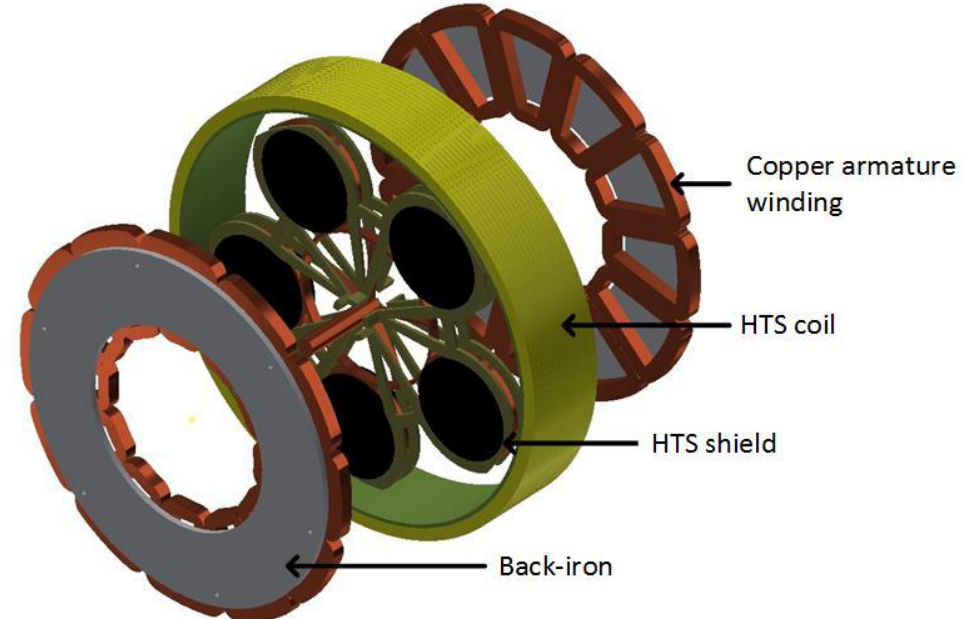
Figure 5. HTS coils producing an axial magnetic field, with HTS bulks as a magnetic shield and armature windings.